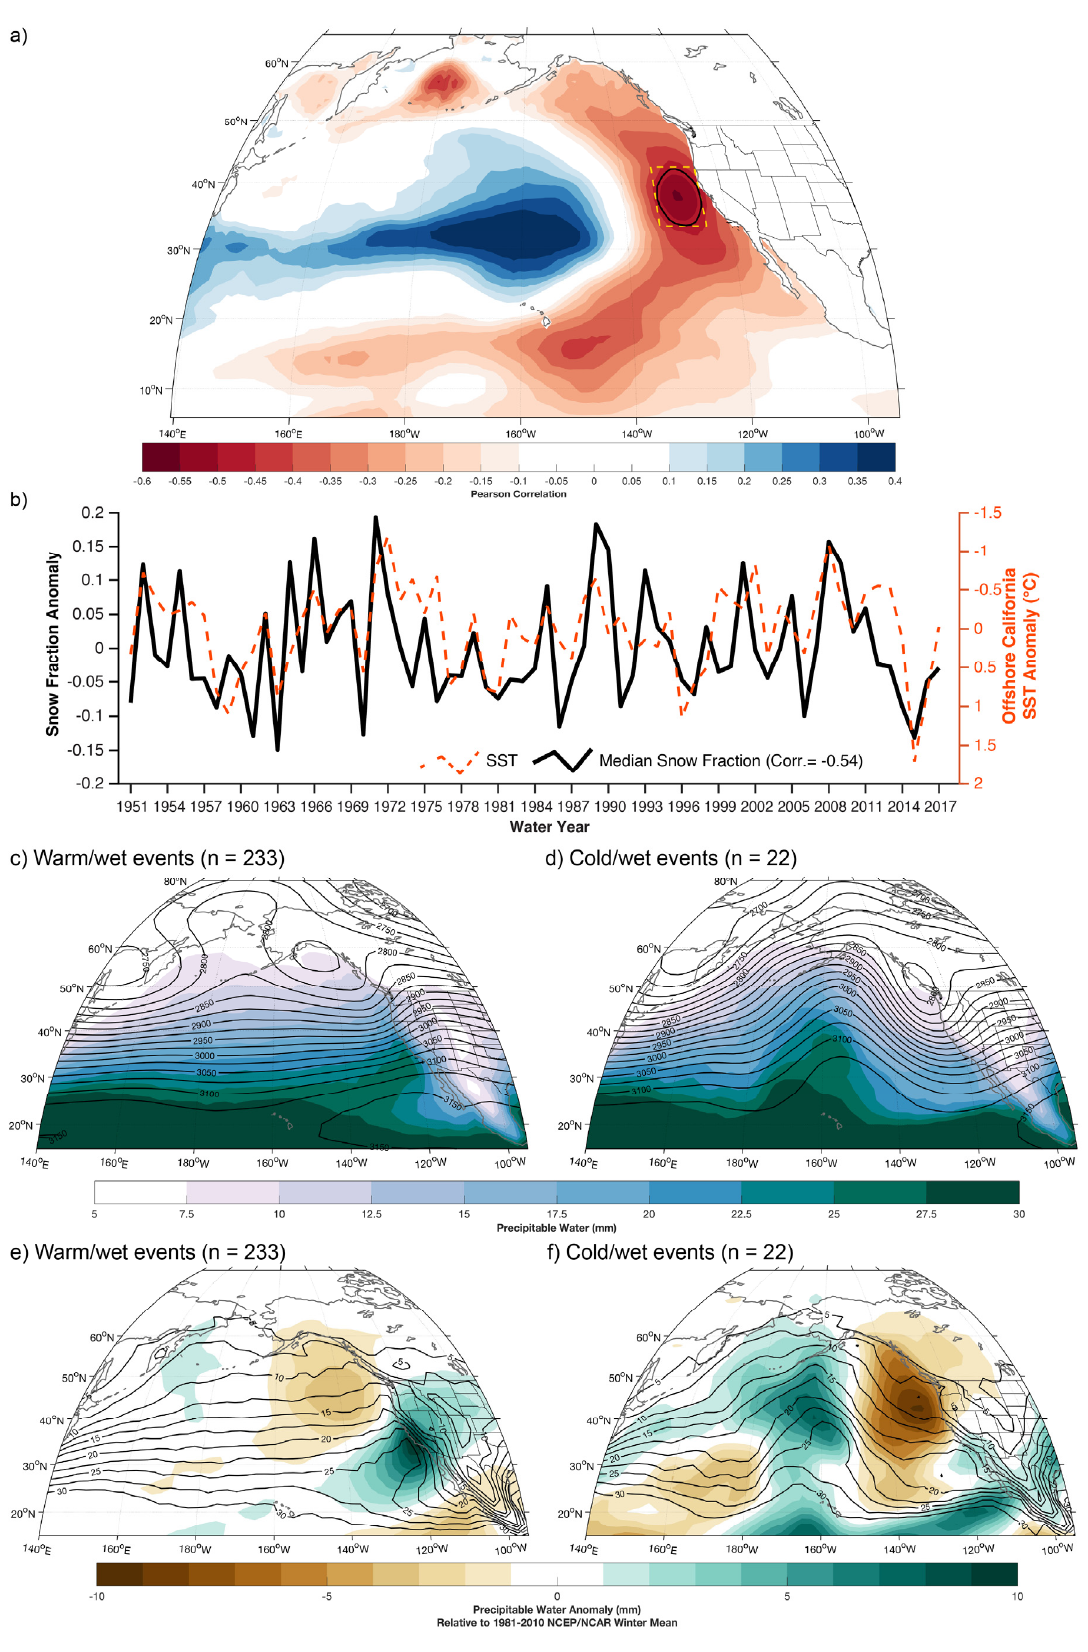
Figure 6. ( a ) Single-point correlations between winter northern Sierra Nevada median snow fraction and sea surface temperatures (SSTs) during WY1951–2017. Black contours encircle grid points at which correlations were statistically significant (p < 0.05). ( b ) Time series of northern Sierra Nevada